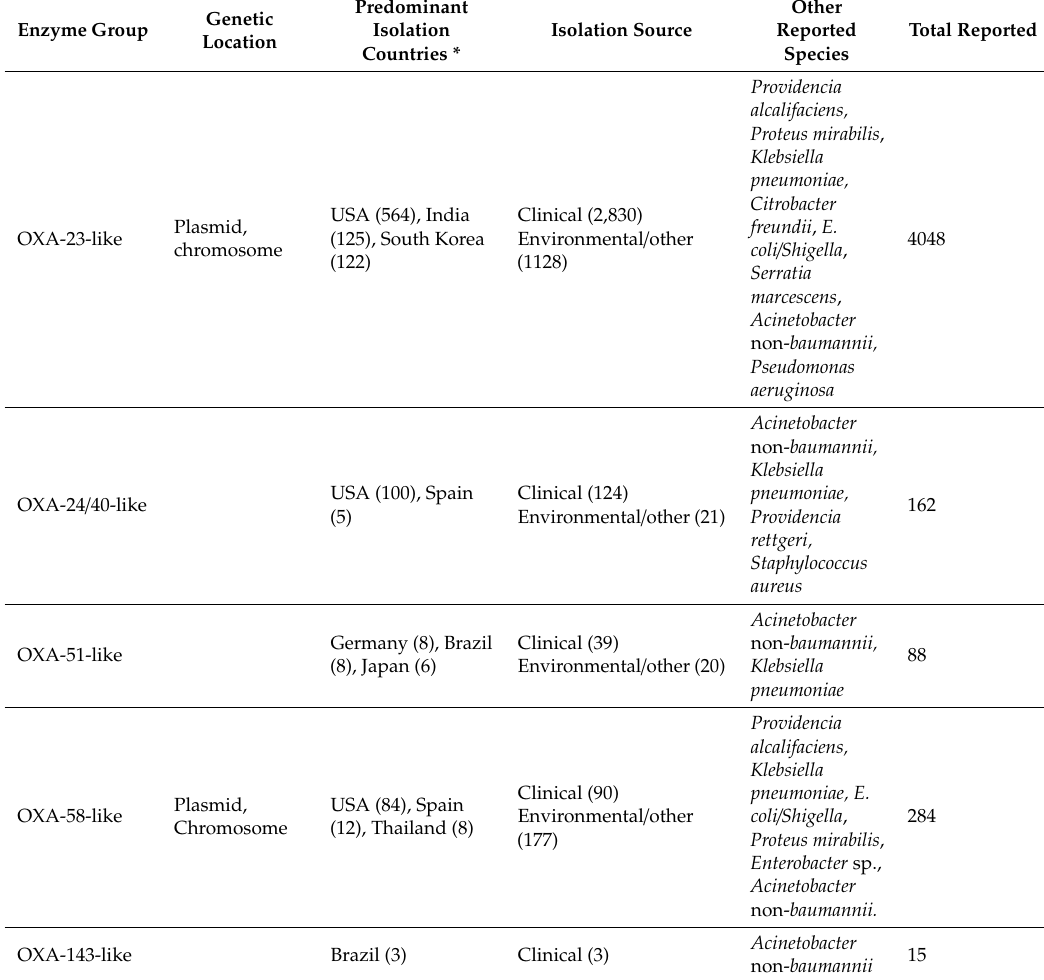
Table 1. OXA enzymes identified in A. baumannii